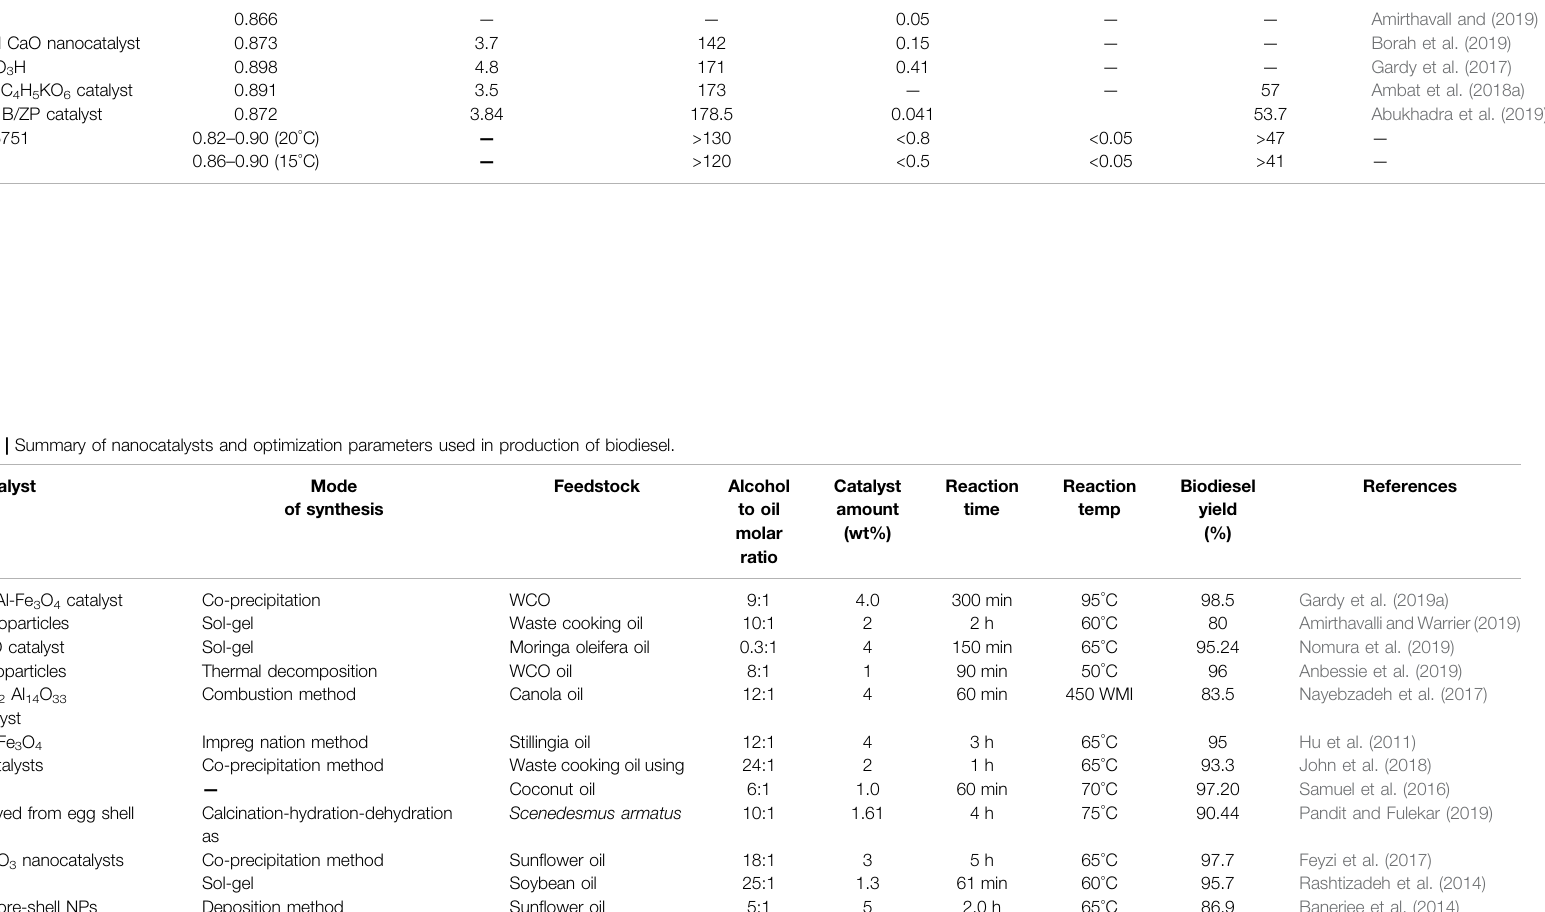
Microwave irradiation (MI).